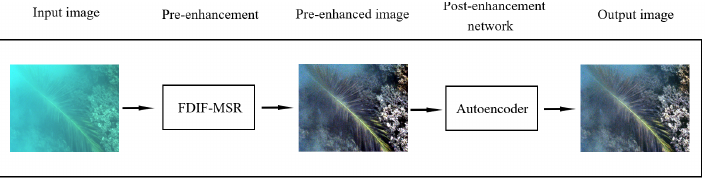
Figure 1. Diagram of the proposed end-to-end underwater-image-enhancement